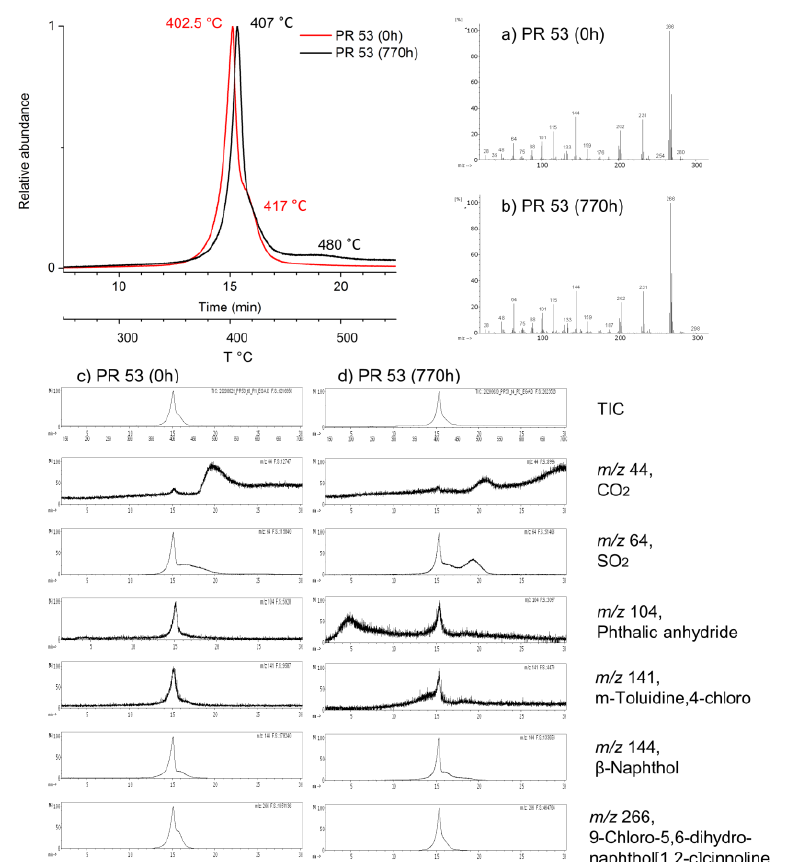
5 Figure 5. EGA-MS curves of the pigment PR 53:1 at 0 h (no aging) and 770 h and related mass spectra: ( a ) average mass spectrum of PR 53:1 at 0 h, ( b ) average mass spectrum of PR 53:1 at 770 h, ( c ) total ion current (TIC) and extracted ions for PR 53:1 at 0 h, ( d ) total ion current (TIC) and extracted ions for PR 53:1 at 770 h. The ion trends are scaled to the largest peak in each